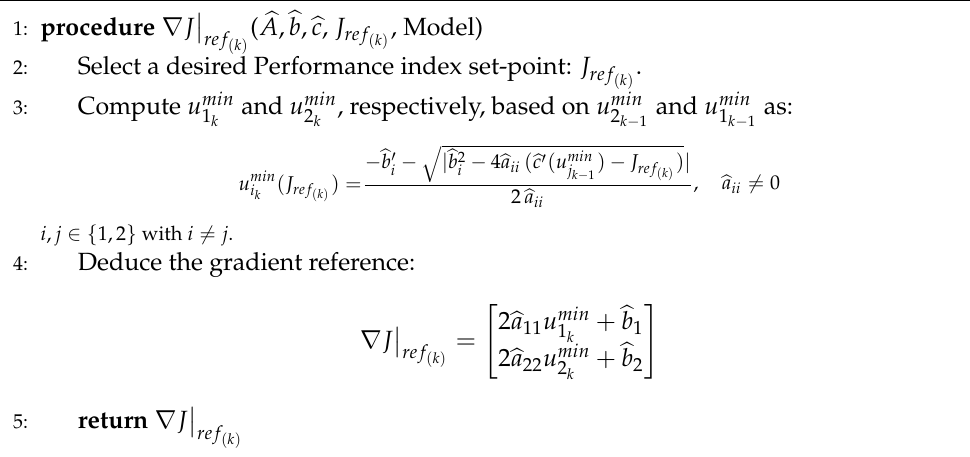
Algorithm 2 Adaptive slope reference generation algorithm for DISO processes—SOP with minimization of both